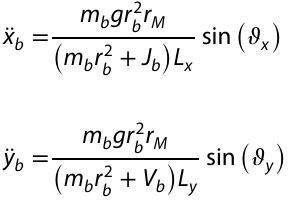
Fig. 4 Block diagram of the system after